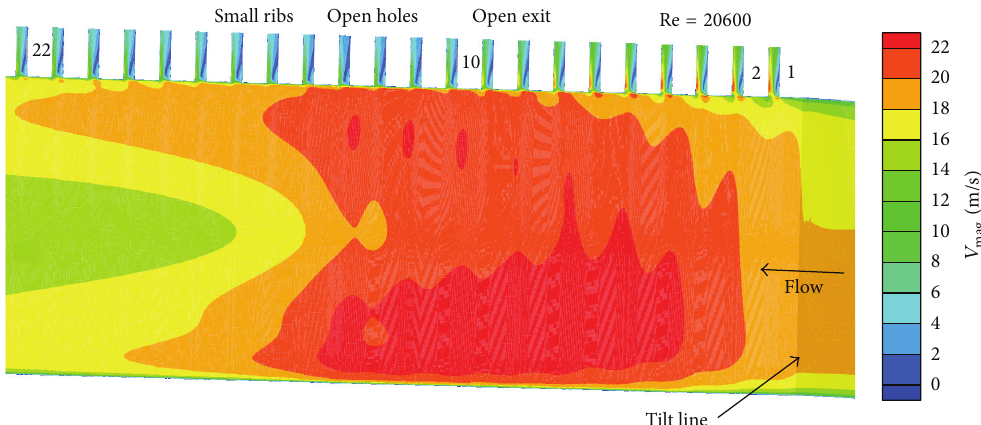
Figure 7: CFD contours of the velocity magnitudes on the channel mid-plane downstream the 22-degree tilt for the small ribs, open trailing- edge holes, and open channel exit.